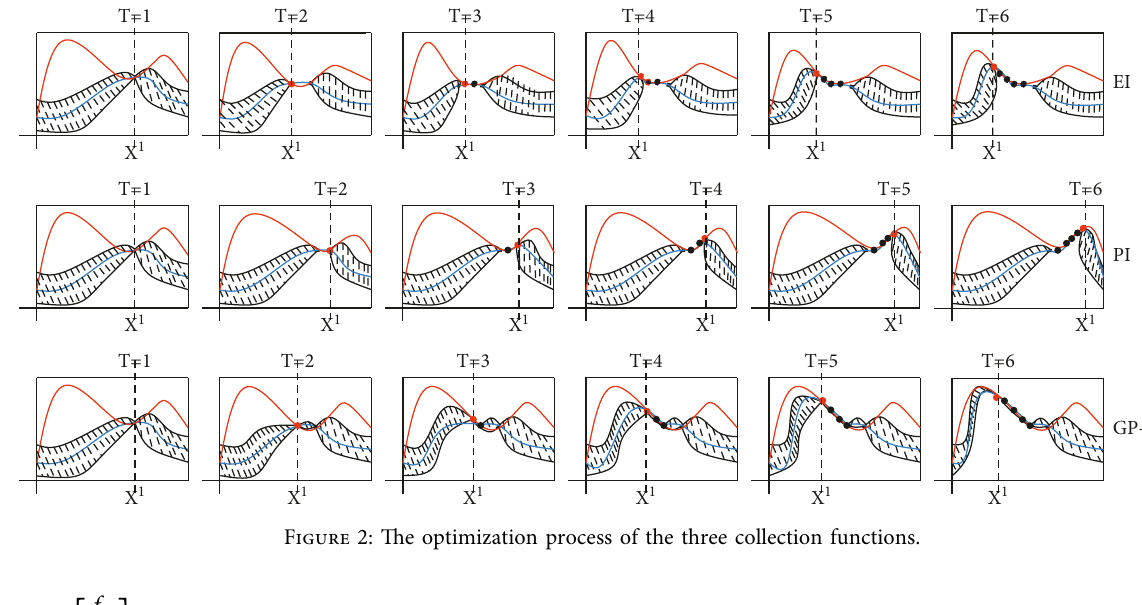
Figure 2: The optimization process of the three collection functions.